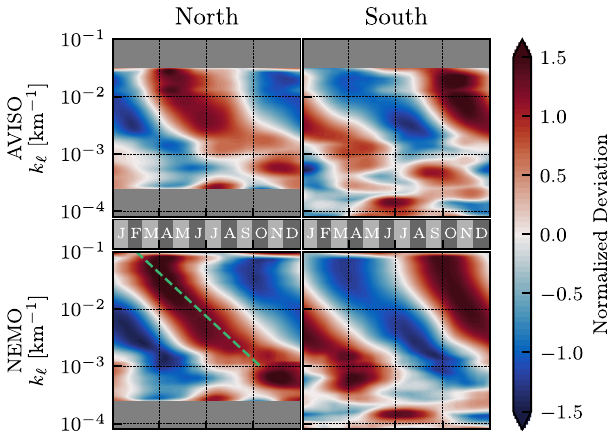
Fig. 3 | Seasonality. Normalized deviation (or z-score) of the 60-day running average of surface geostrophic KE spectrum in [left] NH and [right] SH for both [top]satelliteand[bottom]modeldatasets.Horizontalaxisshowstimebinnedinto months, from January (J) through December (D). Vertical axes show fi ltering wavenumber k ℓ = ℓ − 1 . The greenline inthe bottom leftpanelshows a 100-foldscale increase over 8